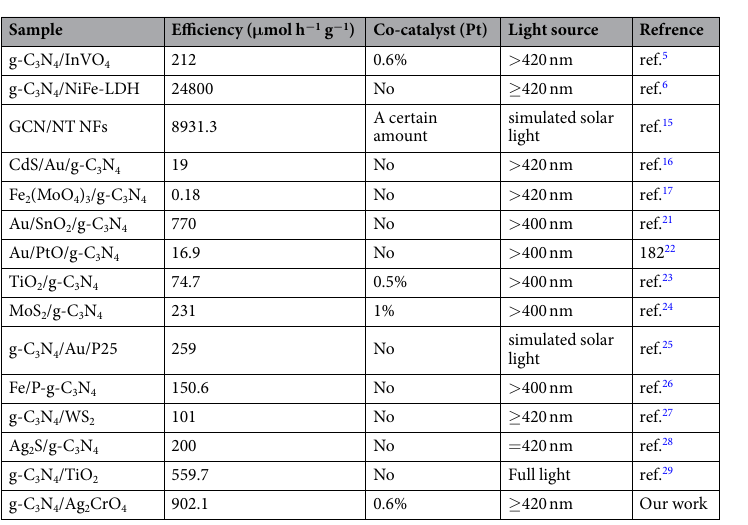
Table 1. Comparison of the photocatalytic H 2 production rate reported in the literatures with Z-scheme g-C 3 N 4 /Ag 2 CrO 4 in our work with methanol as sacrificial agent under visible light